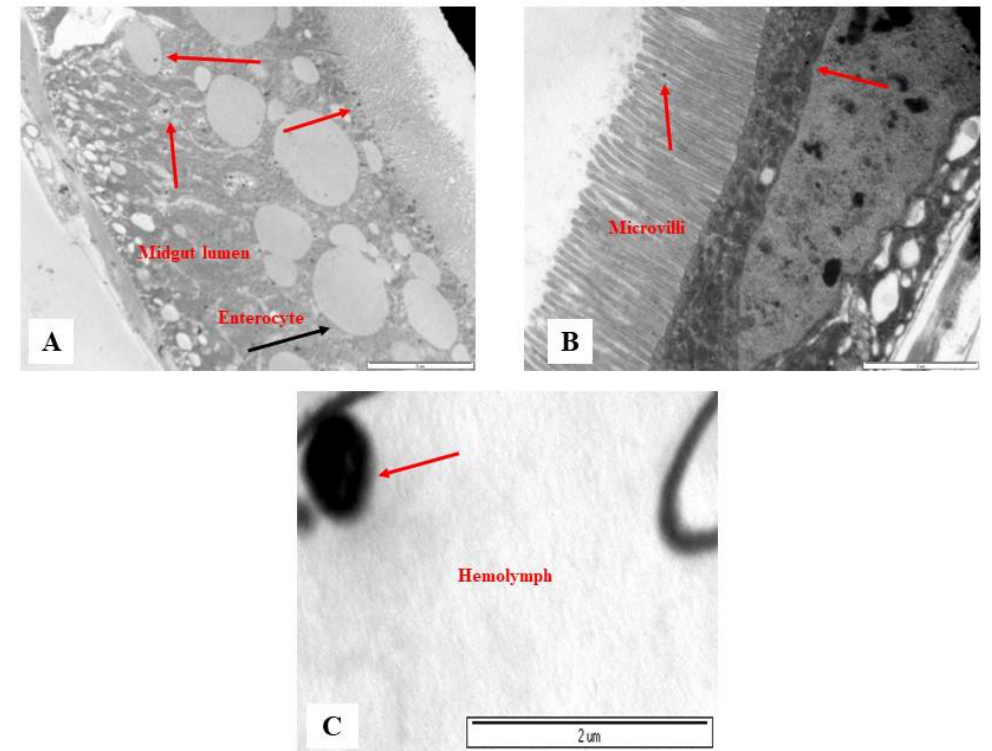
Figure 3. Images of ingested PSMPLs (10 and 20 µ m) from their ingestion until their translocation to the hemolymph compartment. PSMPLs (10 µ m) are distributed inside the midgut lumen ( A ), PSMPLs (20 µ m) are inside the microvilli and distributed inside the midgut lumen ( B ) and, finally, reaching the hemolymph ( C